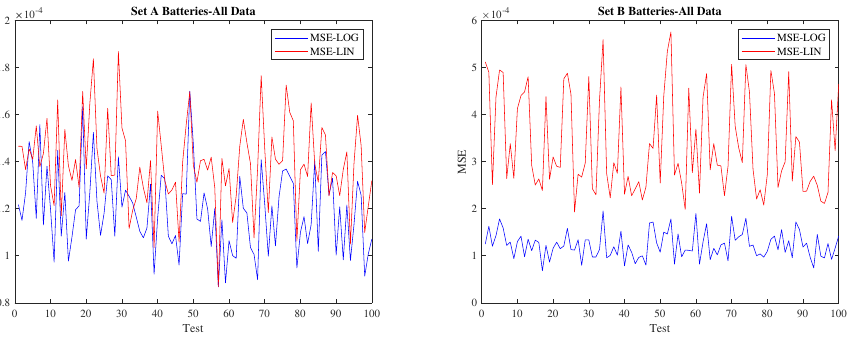
Figure 10. Full-life prediction results for 100 random splits of data